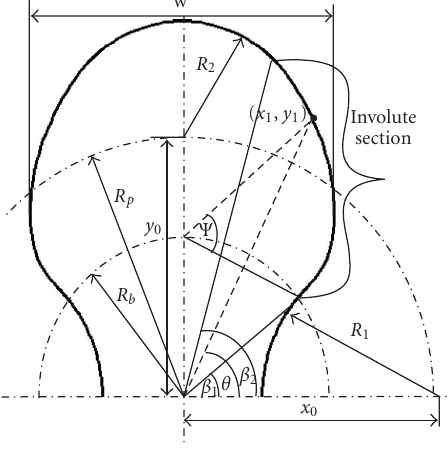
Figure 3: Profile of base